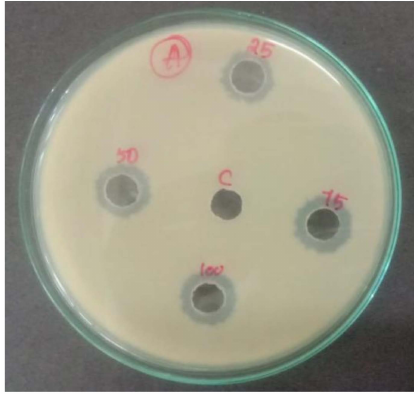
Figure 16. Antibacterial activity of Cu-Zn-Mn mixed trimetal oxide